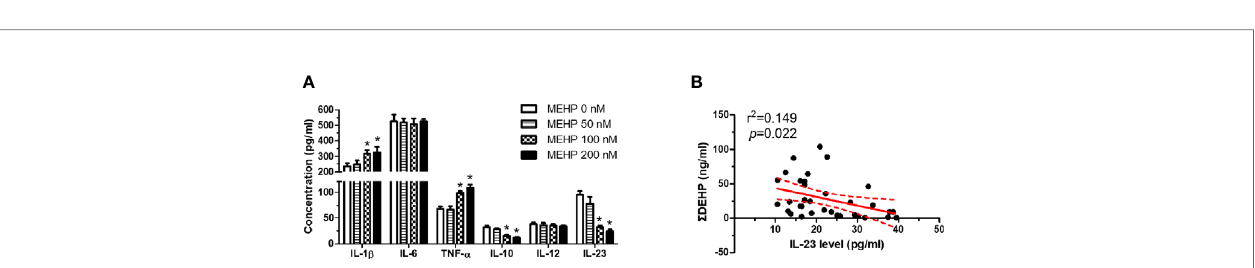
FIGURE 2 | MEHP decreases IL-23 expression in cultured human MDMs. (A) MEHP altered in fl ammatory cytokines in cultured human monocyte-derived macrophages (MDMs). *P < 0.05 MEHP-treated vs. controls by Kruskal-Wallis test; N = 8, means ± SD. (B) Urine MEHP levels correlated negatively with serum IL- 23 levels in dengue virus (DV)-infected patients. N = 43 by linear regression analysis.